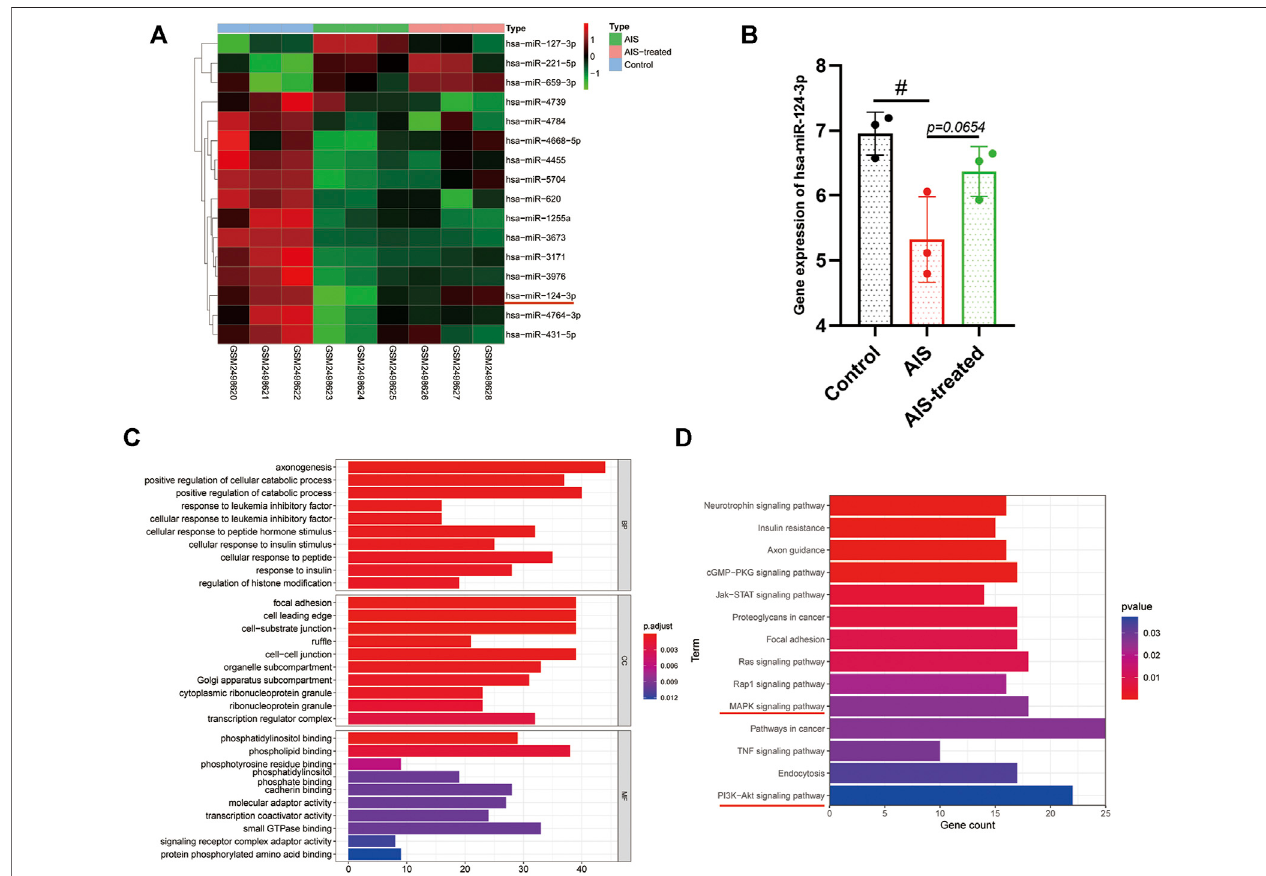
FIGURE 1 | Bioinformatic analysis and the gene expression of hsa-miR-124-3p in AIS and AIS-treated blood samples. (A) Heat map of differentially expressed miRNAsincontrol(none-AIS),AIS,and AIS-treated samples. (B) Geneexpression analysisof hsa-miR-124-3p incontrol(none-AIS),AIS,andAIS-treated samples. # p < 0.05; one-way ANOVA with the Newman – Keuls multiple comparison test. (C,D) GO function and KEGG pathway enrichment of targeted genes of hsa-miR-124-3p .